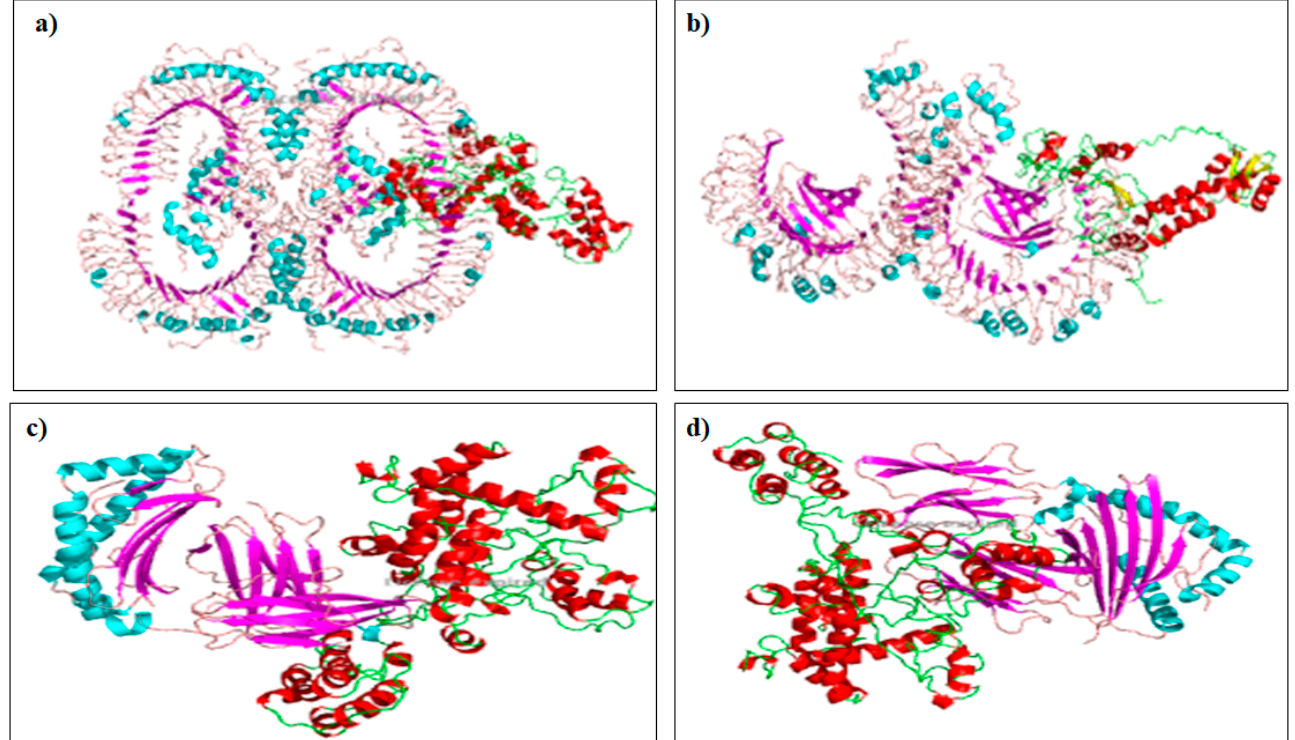
Figure 4. Protein–protein docking results of vaccine construct with TLR-2 ( a ), TLR- 4 ( b ), MHC class I ( c ) and MHC class II ( d